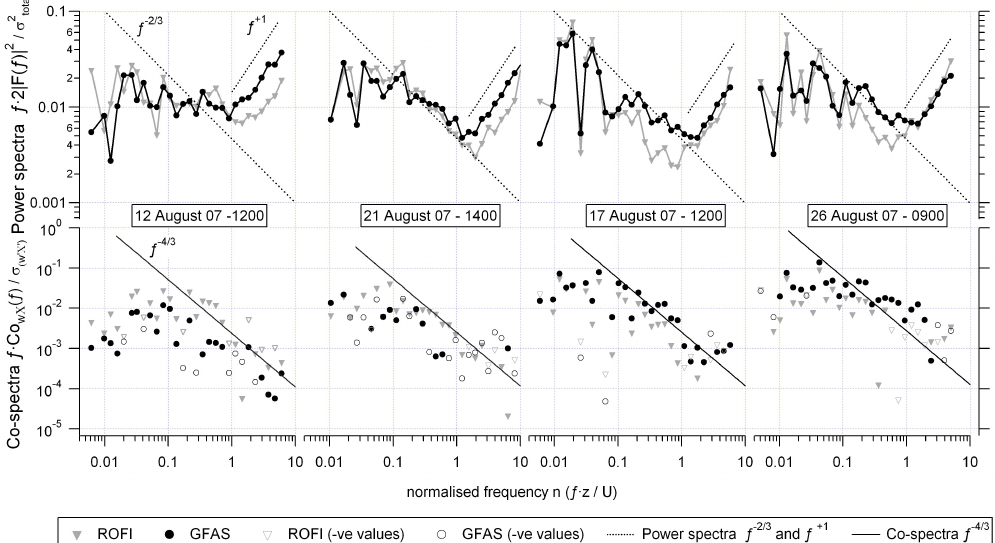
Fig. 7. Frequency weighted power spectra (top panels) for GFAS and ROFI analysers for the 12 and 21 August (when absolute fluxes agree) and 17 and 26 August (when absolute fluxes do not agree) and corresponding co-spectra (bottom panels) showing that high frequency noise in analyser ( f + 1 slope) is not correlated with w 0 and co-spectra follow f − 4 / 3 slope.